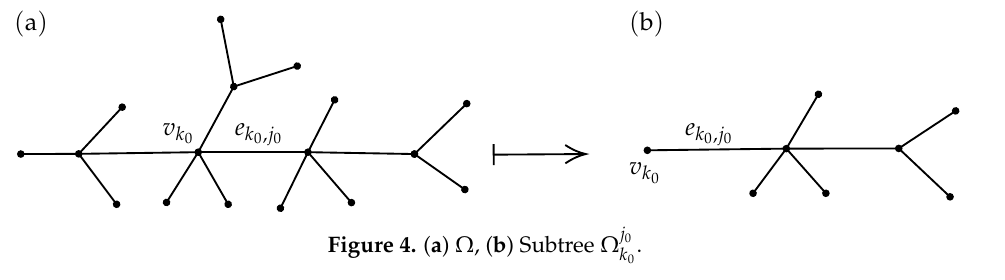
Figure 4. ( a ) Ω , ( b ) Subtree Ω j 0